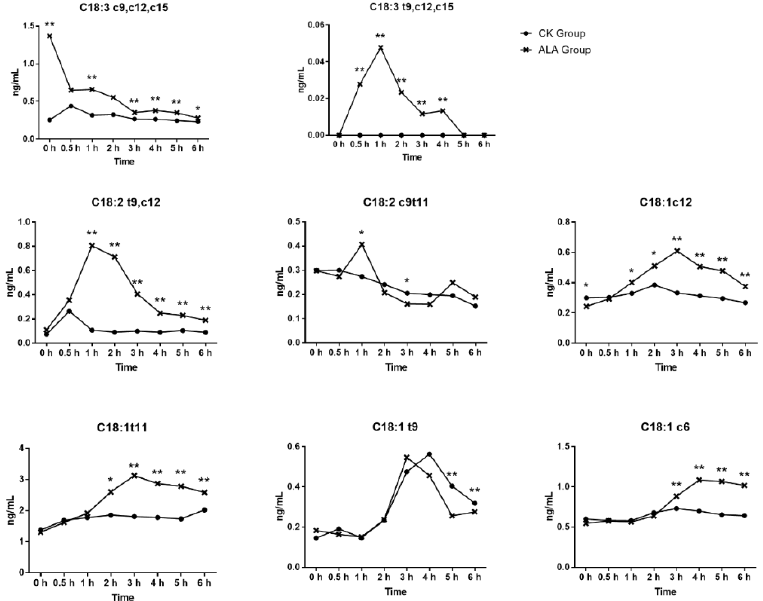
Figure 2. The C18 fatty acid content in fermentation in vitro at separate times. Significant difference: * p < 0.05, ** p < 0.01.